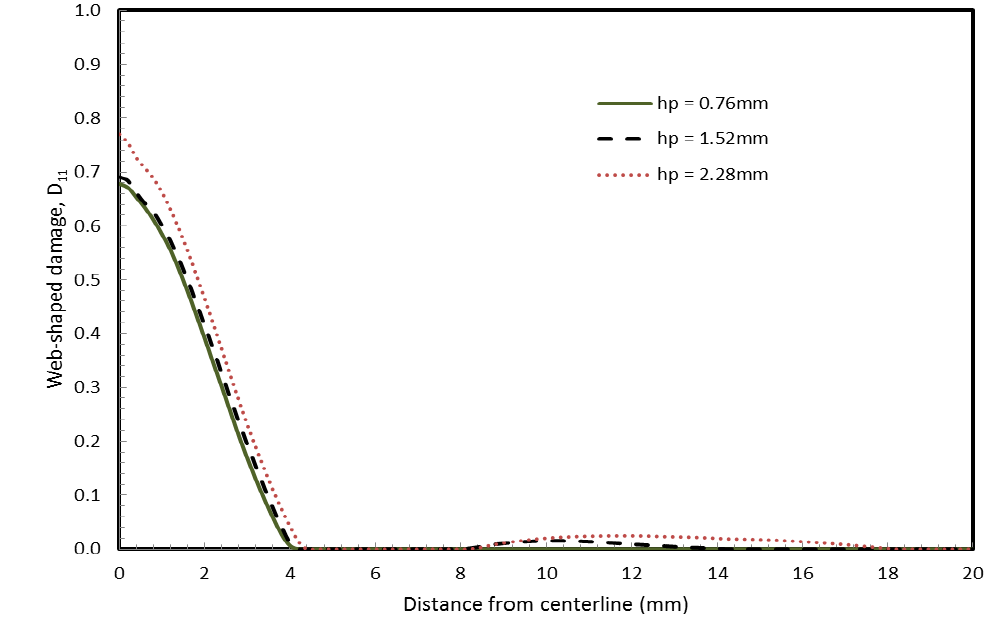
Figure 8. Effect of polyvinyl butyral (PVB) interlayer thickness on web-shaped damage, on surface S2 for small missile D 11